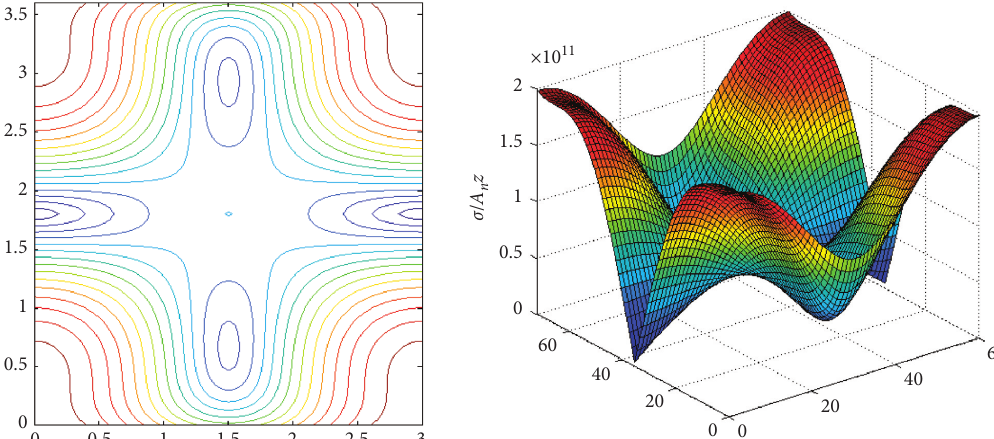
Figure 12: The maximum shear of the 3 rd order mode (S-F-S-F).